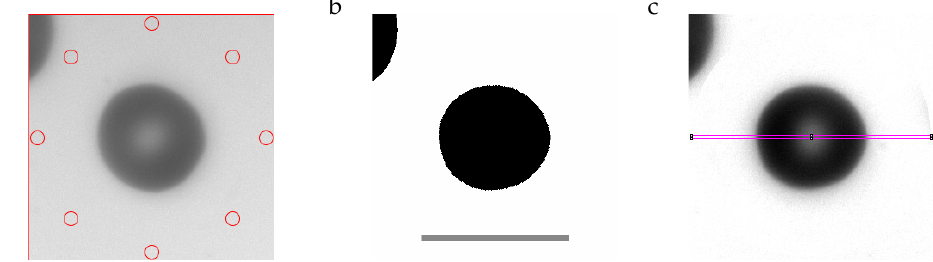
Figure 2. ( a ): cropped image with eight circular regions (red) used for normalizing the gray values (GVs). ( b ): digitized image. The scale bar indicates 10µm. ( c ): image after normalizing the GVs. The rectangle (magenta) is used for evaluating the GV-profile. The RBC in ( b , c ) is rotated to make the major axis horizontal. For more details see text.